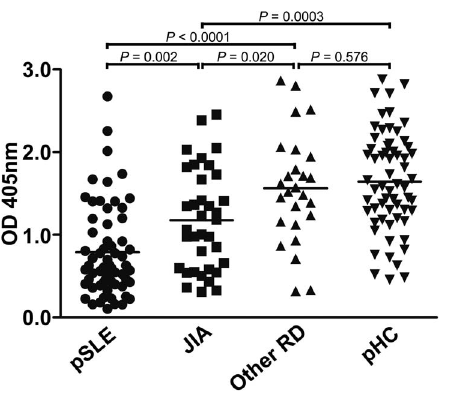
Figure 2. Comparison of IgM anti-H3 1 – 19 K9me levels in patients and healthy subjects. Anti-H3 1–19 K9me IgM levels in pSLE patients (n=62), JIA patients (n=36), other RD patients (n=26, including juvenile ankylosing spondylitis, Henoch-Schonlein purpura, idiopathic thrombocytopenic purpura, Kawasaki disease, mixed connective tissue disease, juvenile dermatomyositis and Behcet’s disease) and pHC (n=62) were measured by ELISA. Microtiter plates were coated with the H3 1–19 K9me peptide conjugated to BSA. The serum samples were diluted 1:100 and tested. The KT16 anti-human IgM mAb was used as the primary Ab, and HRP-conjugated goat anti-mouse IgG was used as the secondary Ab. The horizontal bars indicate the mean values in each group. P values were calculated using the Student’s t test.